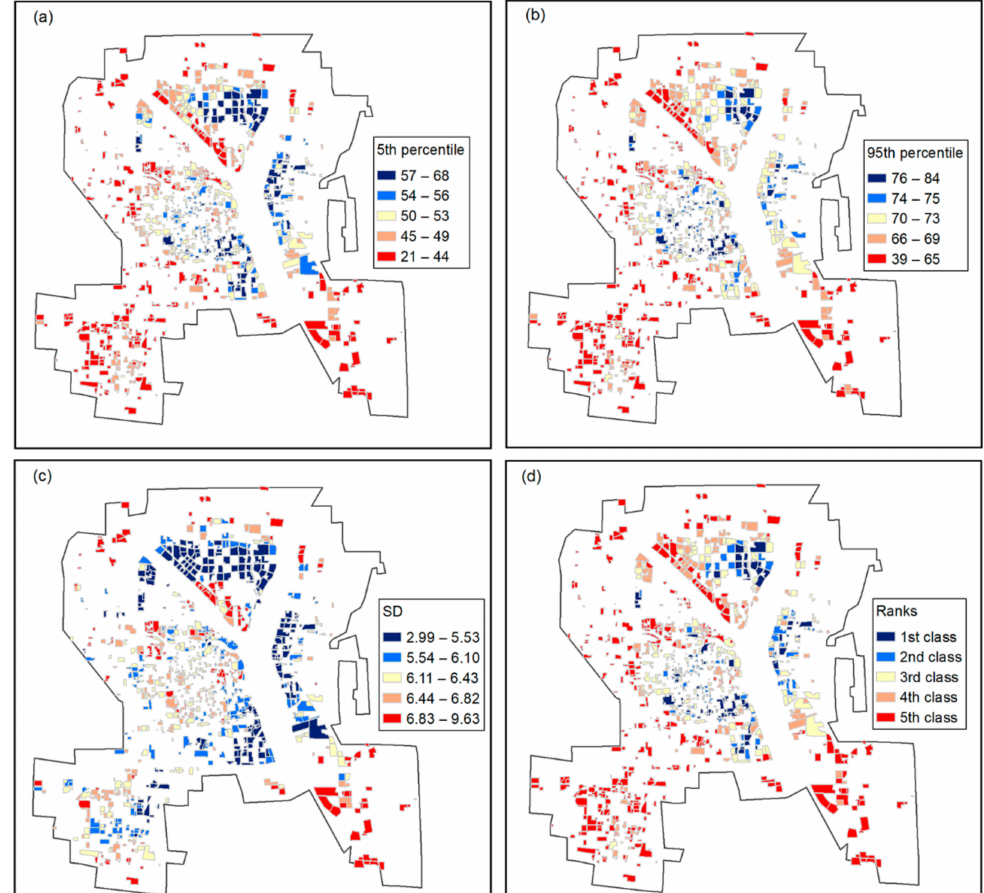
Figure 9. Spatial patterns of livability scores and its uncertainty for all communities. ( a ) The 5th percentile of livability scores from Monte Carlo simulations. ( b ) The 95th percentile of livability scores from Monte Carlo simulations. ( c ) The standard deviation of livability scores from Monte Carlo simulations. ( d ) Five livability ranks classified using the quantile method. The communities of the first class were the ones whose scores were above 90th percentile, the second-class communities were the ones whose scores were within the range from 81th to 90th percentile, the third-class communities were the ones whose scores were within the range from 61th to 80th percentile, the fourth-class communities were the ones whose scores were within the range from 41th to 60th percentile, and the fifth-class communities were the ones whose scores were below 40th